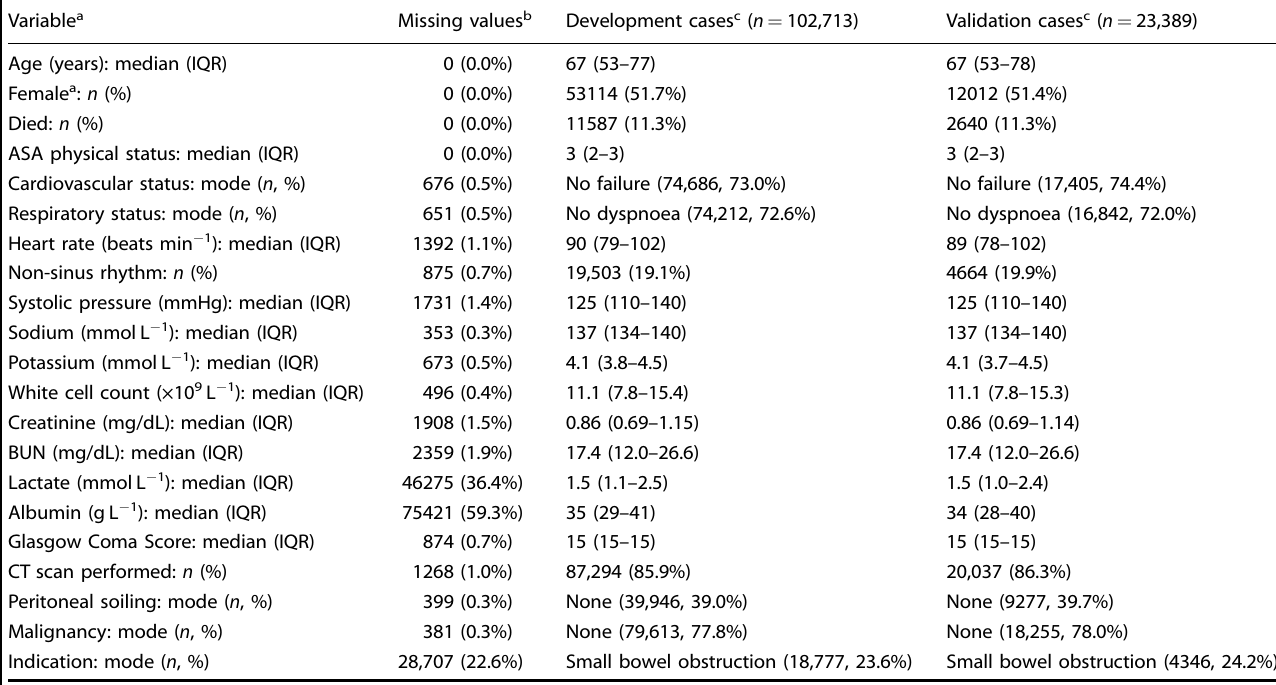
Table 1. Demographic information and RUNE covariates.